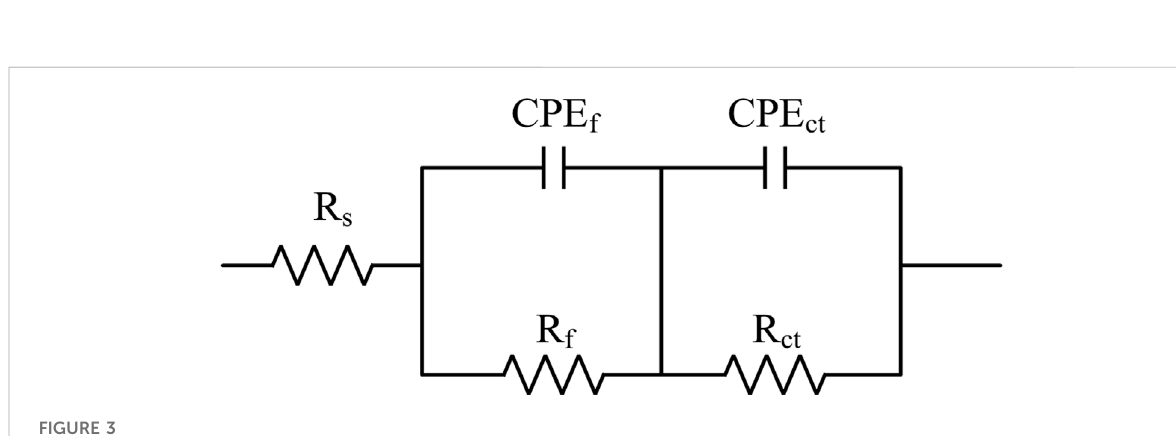
FIGURE 3 The equivalent electrical